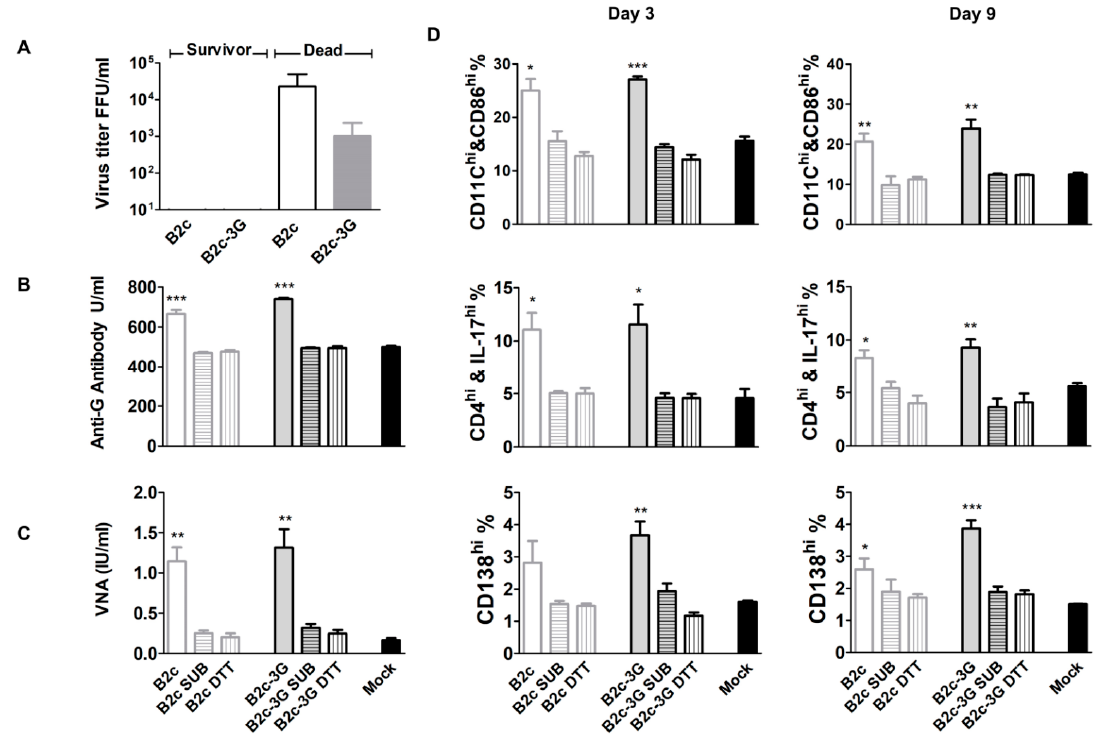
Figure 7. Removal of G from RABV virions abolished immune activation. ( A ) Viral titers in the brains of dead and surviving mice. ( B ) VNAs in mice infected with different viruses. ( C ) ELISA of anti-RABV-G antibodies in mice infected with different viruses. ( D ) FACS analysis of the activation status of DCs, T cells, and B cells in the spleens of mice infected with different viruses at 3 or 9 dpi. The significance of differences between the positive cell percentages in mock and infected mice were assessed by the unpaired t -test. *, p < 0.05; **, p < 0.01; ***, p < 0.001.